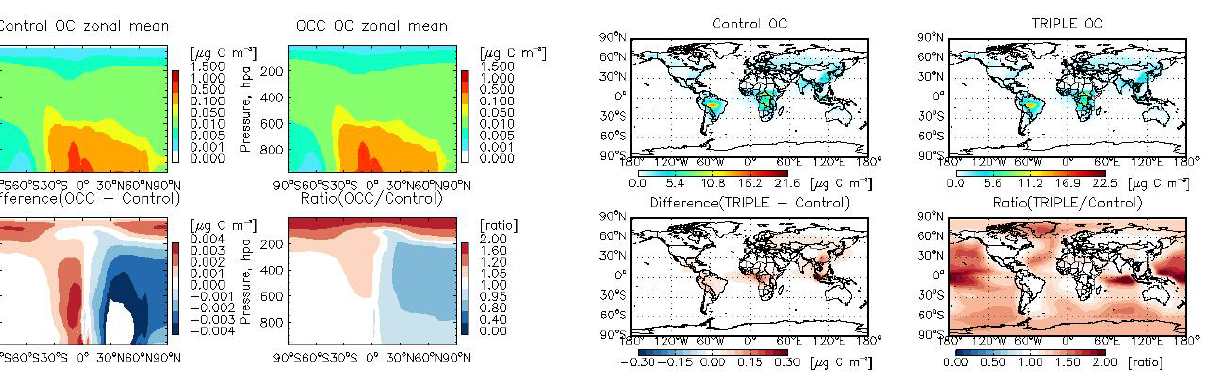
Fig. 6d. Same as Fig. 6b but for zonal mean.